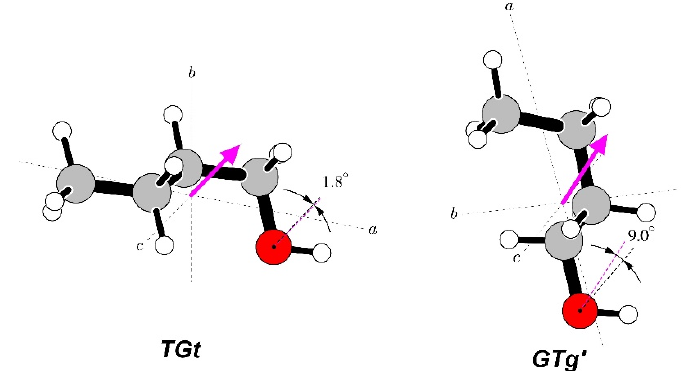
Figure 7. Orientations of the measured electric dipole moments in the two studied conformers of n - butanol. Both molecules, as in the case of n -propanol, have been rotated such that the COH atom chains are in the plane of the diagram at a comparable orientation. Dipole moment directions are compared at the oxygen atoms with ∠ COH bisectors and, as in n -propanol, are seen to be almost coincident for the most stable TGt conformer, while in the GTg’ conformer, the positive direction of the dipole moment is significantly distorted in the direction of the aliphatic chain.